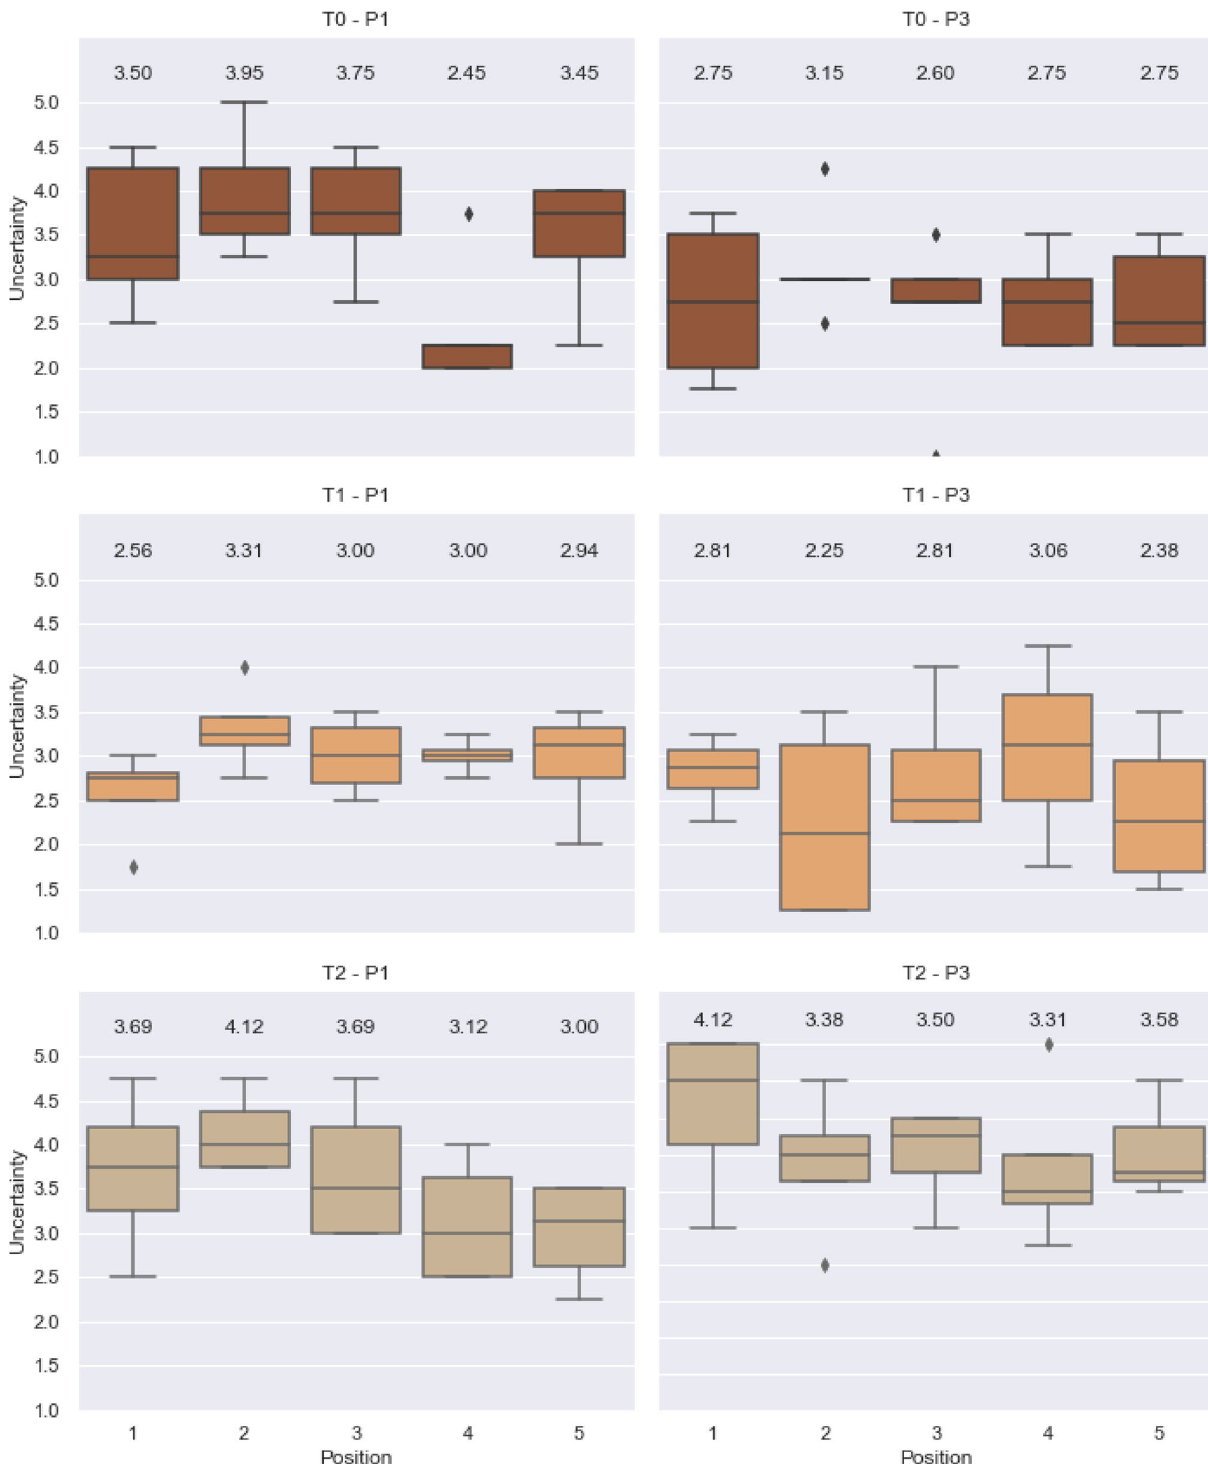
Figure 5. Perception of uncertainty by position (averages above the